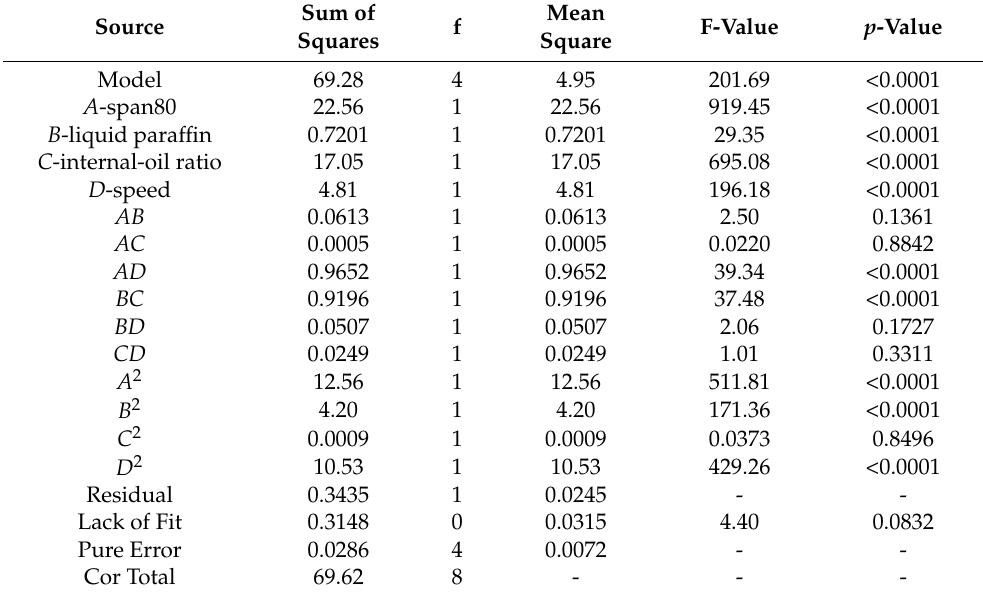
Table 3. ANOVA analysis of RSM model with BBD